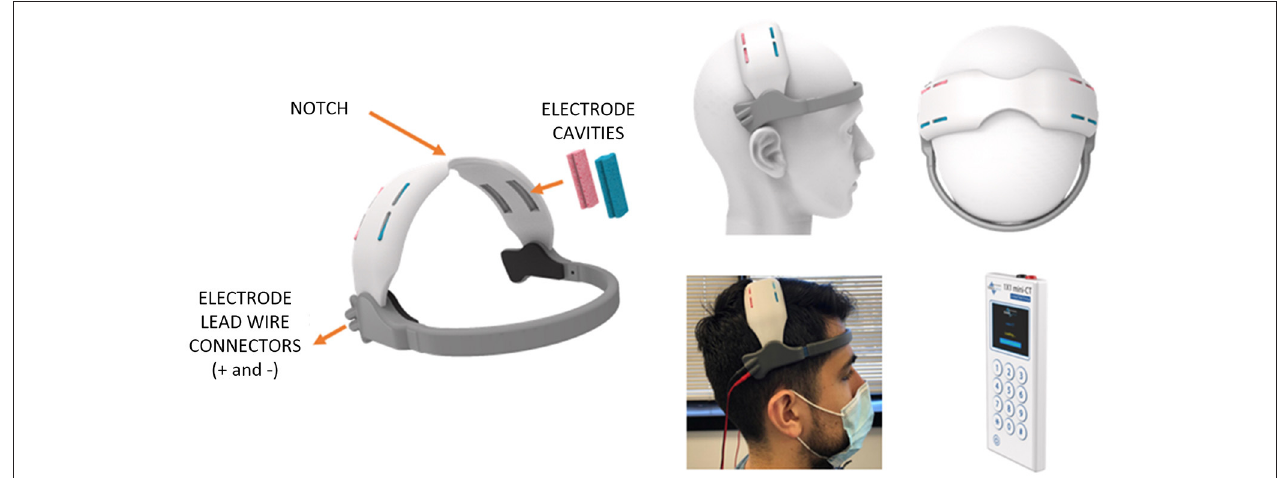
FIGURE 2 | Model-driven design of home-based HD-tDCS application for bilateral M1 stimulation.